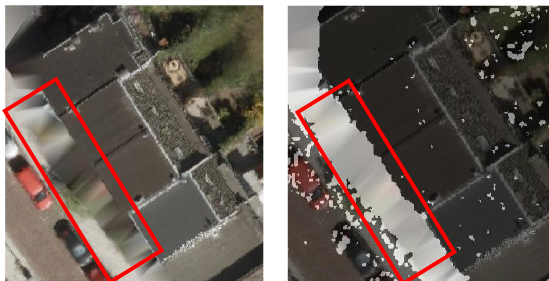
Figure 5. The blurred pixels shows the occluded area (inside the red